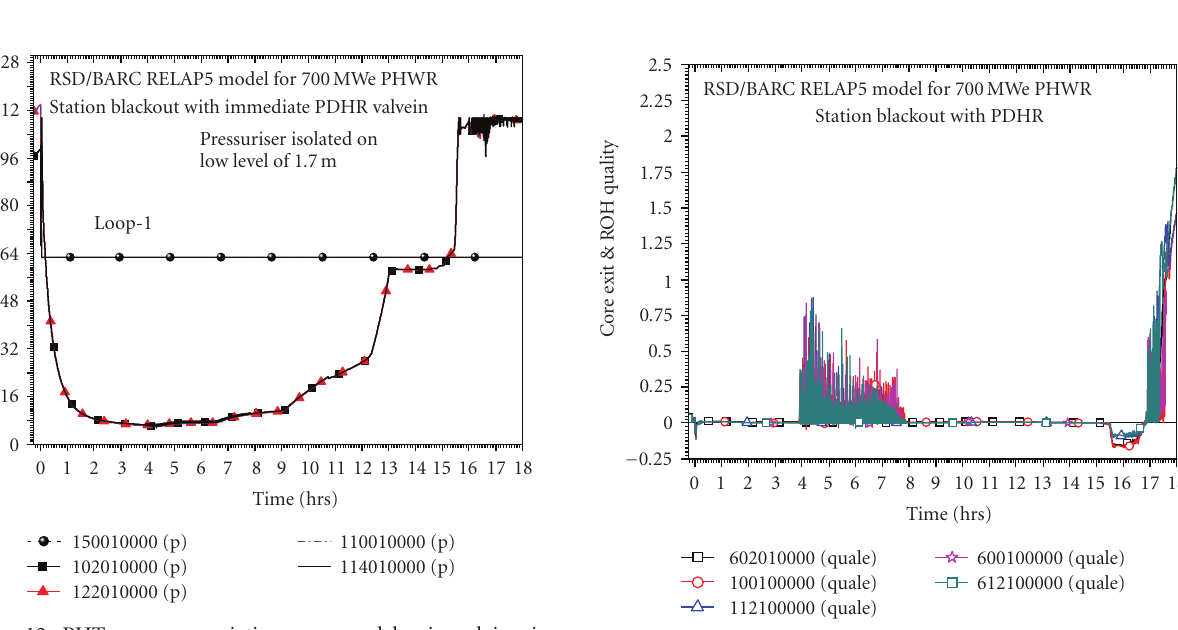
Figure 14: Core exit quality variation case-no delay in valving in